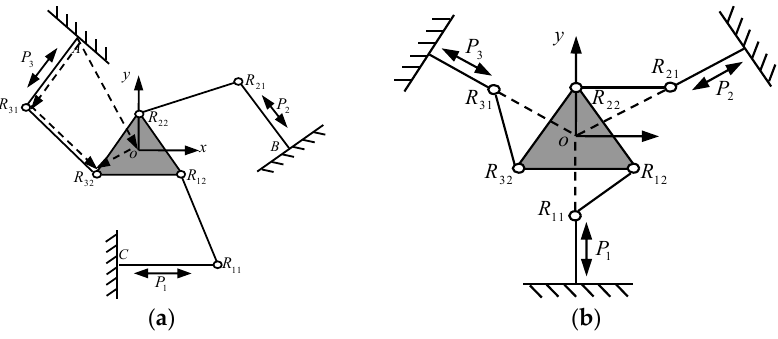
Figure 1. Structure of 3-PRR planar parallel prototype manipulator, ( a ) active pairs intersected with each other; ( b ) active pairs intersected at a point.